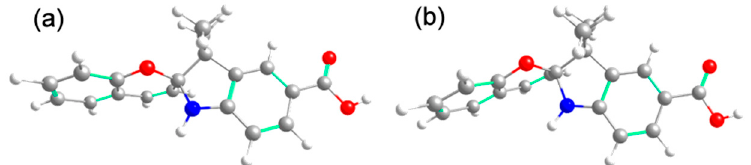
12 of 17 Figure 7 . Stern–Volmer equation plots of BSA fluorescence intensity vs. spiropyran concentration in the suppression experiment (left) and log-log plot of BSA fluorescence intensity vs. spiropyran concentration (right) used to obtain the binding constant (K a ) and binding sites (n) from Equation (5).